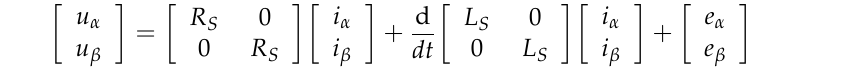
Figure 5. Testing result: current waveform of FOC mode.